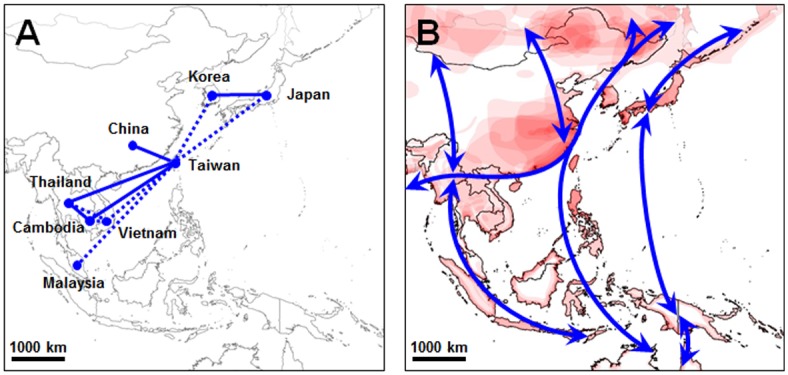
Potential expansion of O. tsutsugamushi clones throughout the endemic region.A. Linkage map indicates the presence of identical (solid line) or sub-identical (one or two base difference, dotted line) tsa56 genes in geographically distant endemic countries. B. The East Asia/Australasia major flyway of migratory birds is presented as blue lines. The primary habitats of 21 key bird species in the flyway are overlaid on the regional map (Data available at http://www.eaaflyway.net/).